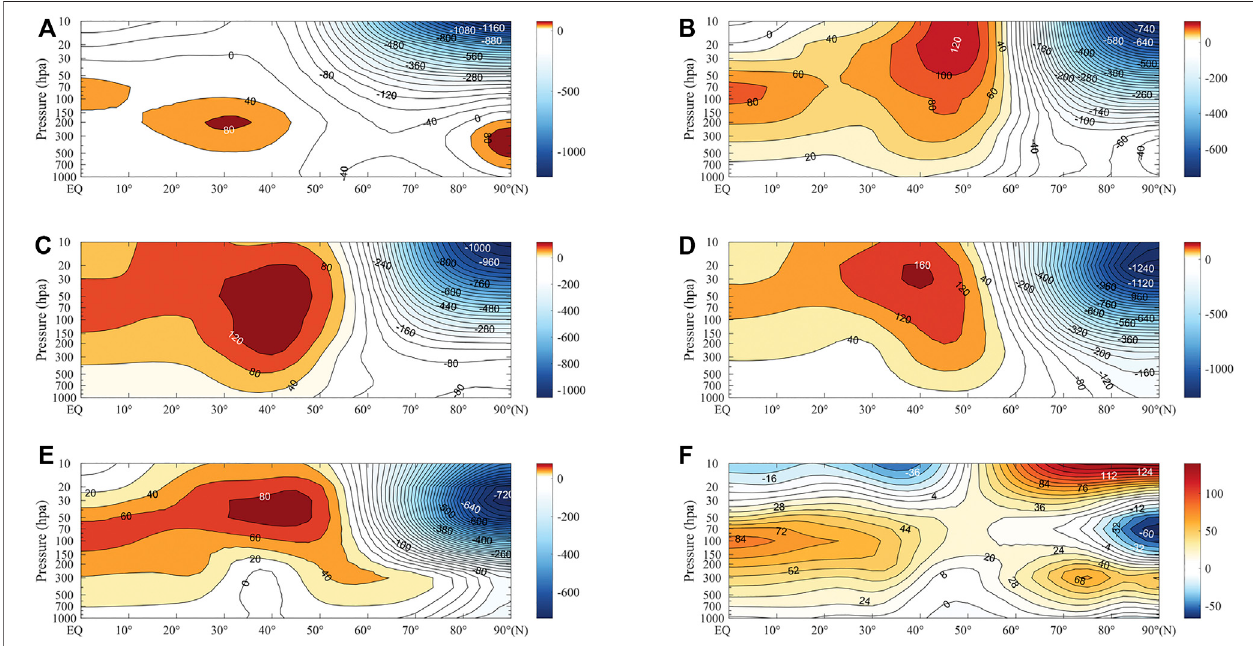
FIGURE5| Monthlyverticalpro fi lesofthezonal-averageGHAintheNorthernHemispherein (A) December2019, (B) January2020, (C) February2020, (D) March 2020, (E) April 2020, and (F) May 2020.